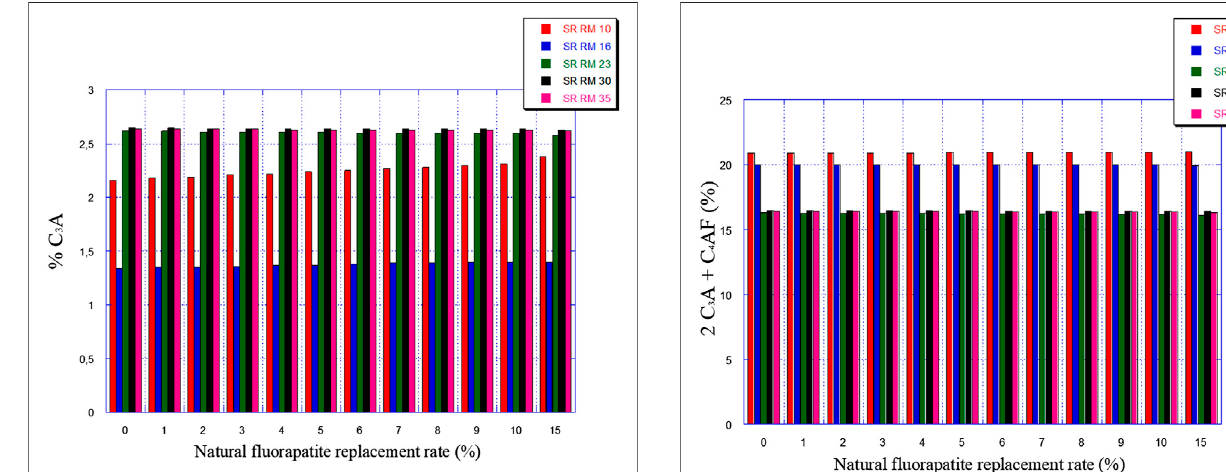
natural fl uorapatite